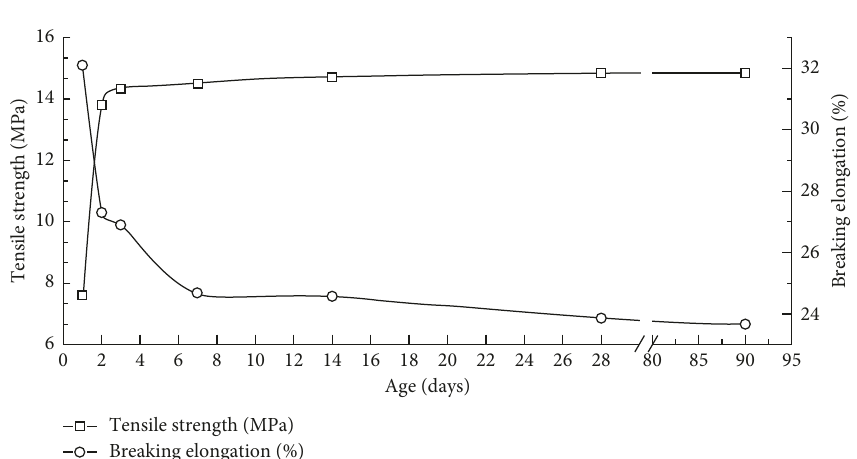
Figure 3: Influence of curing time on elastic epoxy material’s tensile properties with the A/B ratio 7:3.